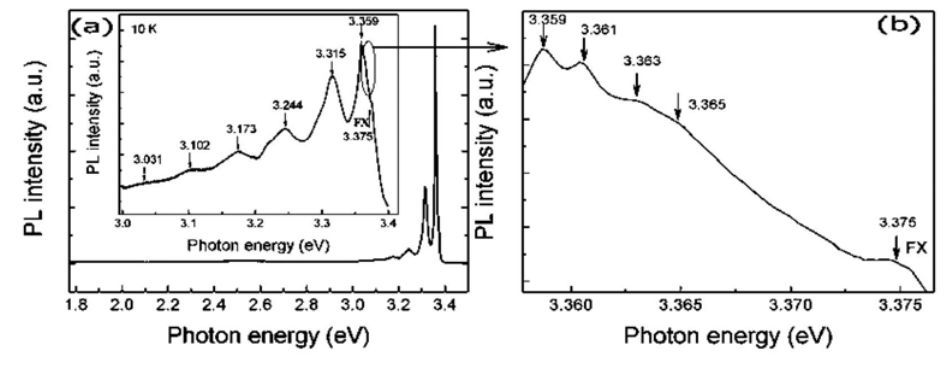
Figure 18. PL spectrum of ZnO nanowires measured at 10 K, (a) for photon energy ranging from 1.77–3.5 eV. The inset is the part in the near-band edge region (3.0–3.4 eV) in a magnified scale. (b) High resolution high energy shoulder in near-band edge emission. Reprinted from Ref. [126] with